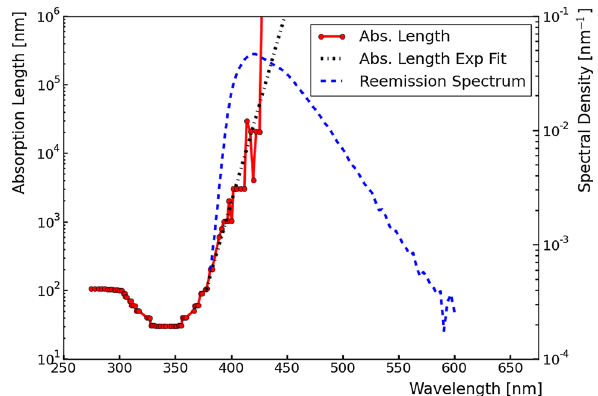
Fig. 11 Absorption length of photons in TPB in nanometers plotted with the area normalized reemission spectrum of TPB. The absorption was taken from [19] while the reemission spectrum was measured in this work